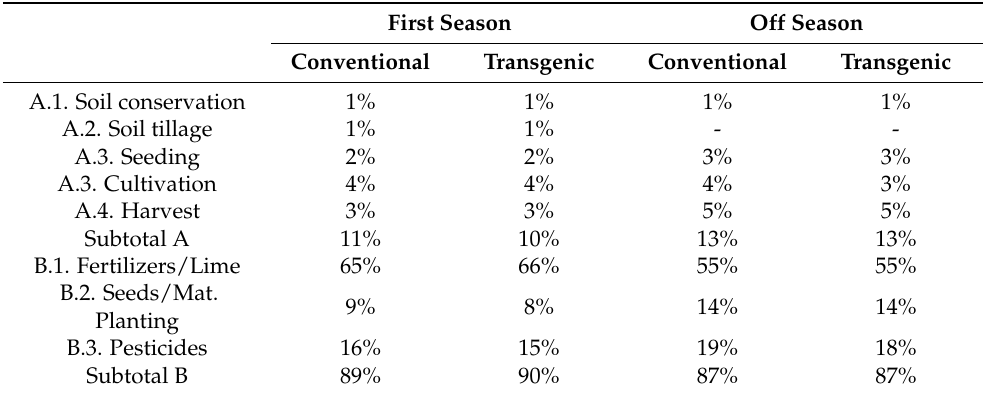
Table 5. Shares of operations and inputs in energy demand for conventional and transgenic corn of the first and off